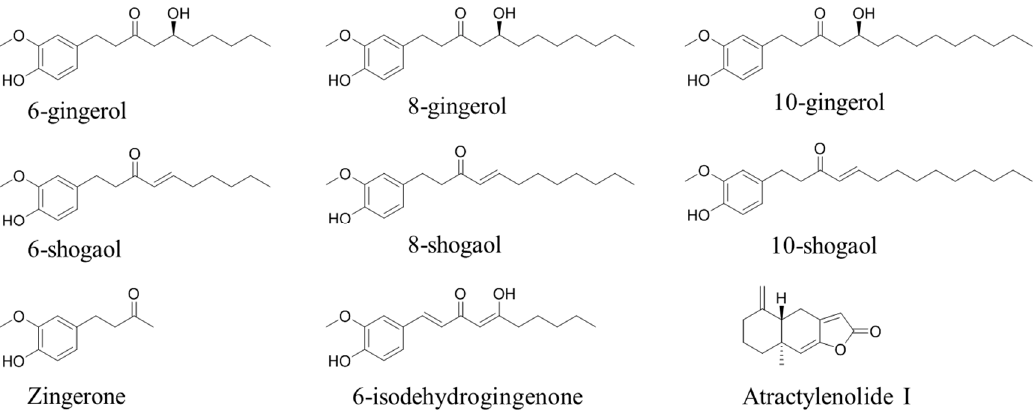
Figure 1. Chemical structures of eight target analytes and Atractylenolide I, the internal standard (IS).